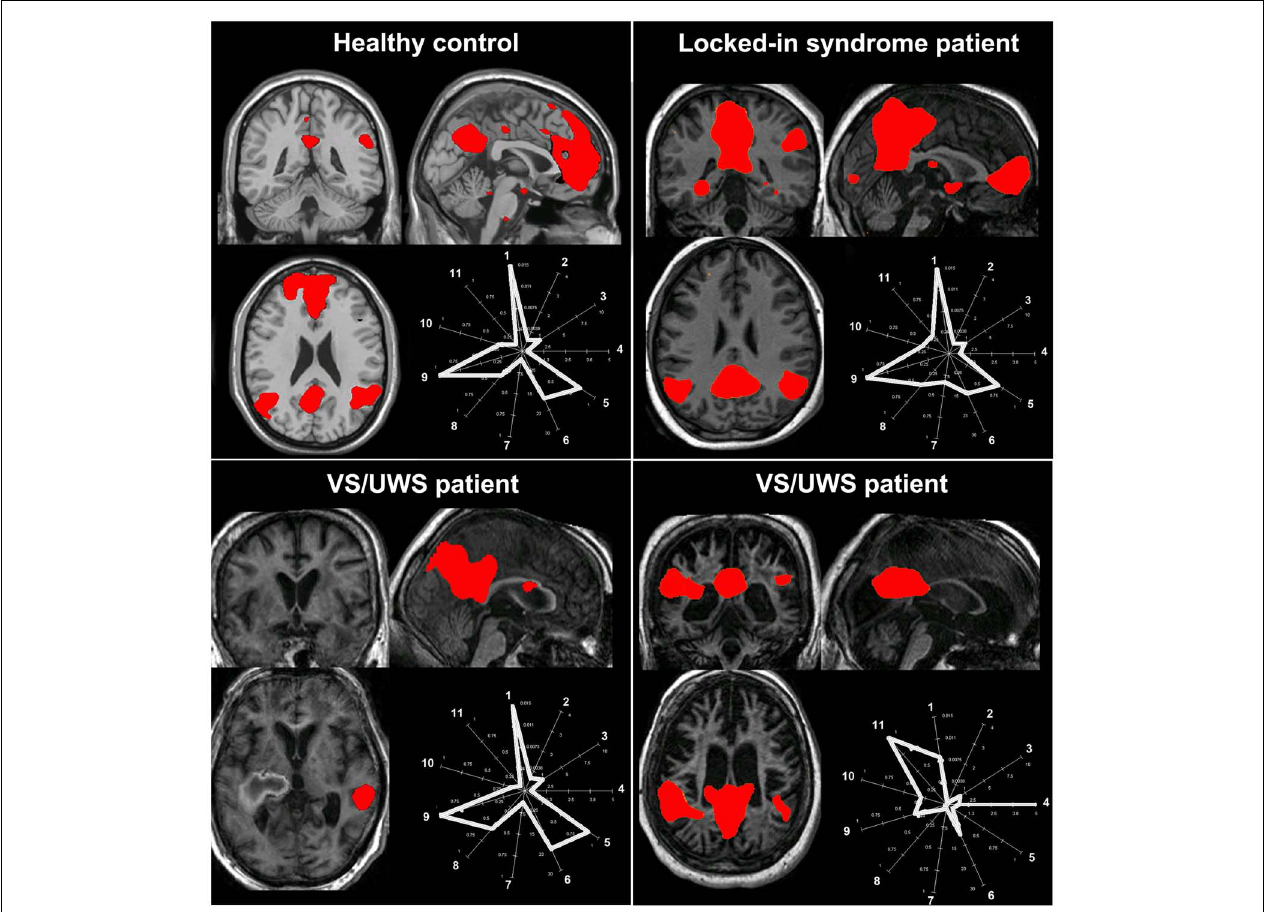
patient exhibits the spatial pattern of the default mode network but importantly the time course of this component is characterized by high frequency fluctuations, in the 0.1–0.25Hz frequency band and high spatial entropy (labeled, respectively, with the number 11 and 4 in the fingerprint). Therefore, such activity cannot be considered of neuronal origin. As a consequence, if the component selection was merely based on a spatial similarity test (e.g., with a predefined template), then this component could be erroneously selected and further statistically analyzed. A “compromise” in the selection of the appropriate network of interest in the space and time domain is needed to will eventually exclude non-neuronal contributions [Fingerprint labels: (1) degree of clustering, (2) skewness, (3) kurtosis, (4) spatial entropy, (5) autocorrelation, (6) temporal entropy, power: (7) 0–0.008Hz, (8) 0.008–0.02Hz, (9) 0.02–0.05Hz, (10) 0.05–0.1Hz, (11)